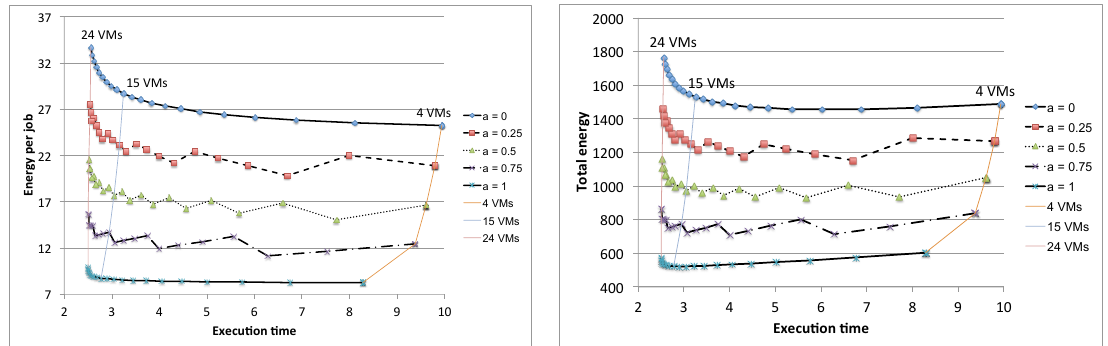
Figure 21. Heterogeneous environment: energy per job ( left ) and total energy ( right ) with asynchronous access.